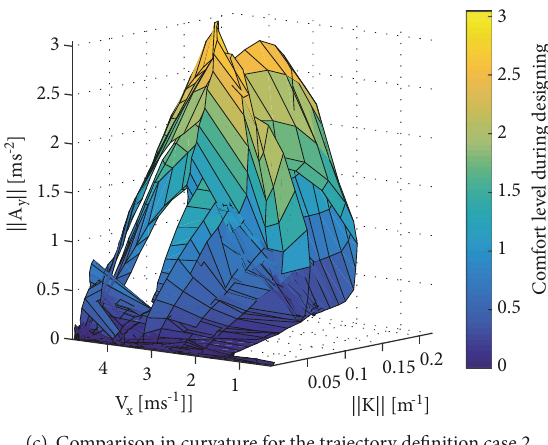
Figure 10: Real life validation of the B´ezier planning